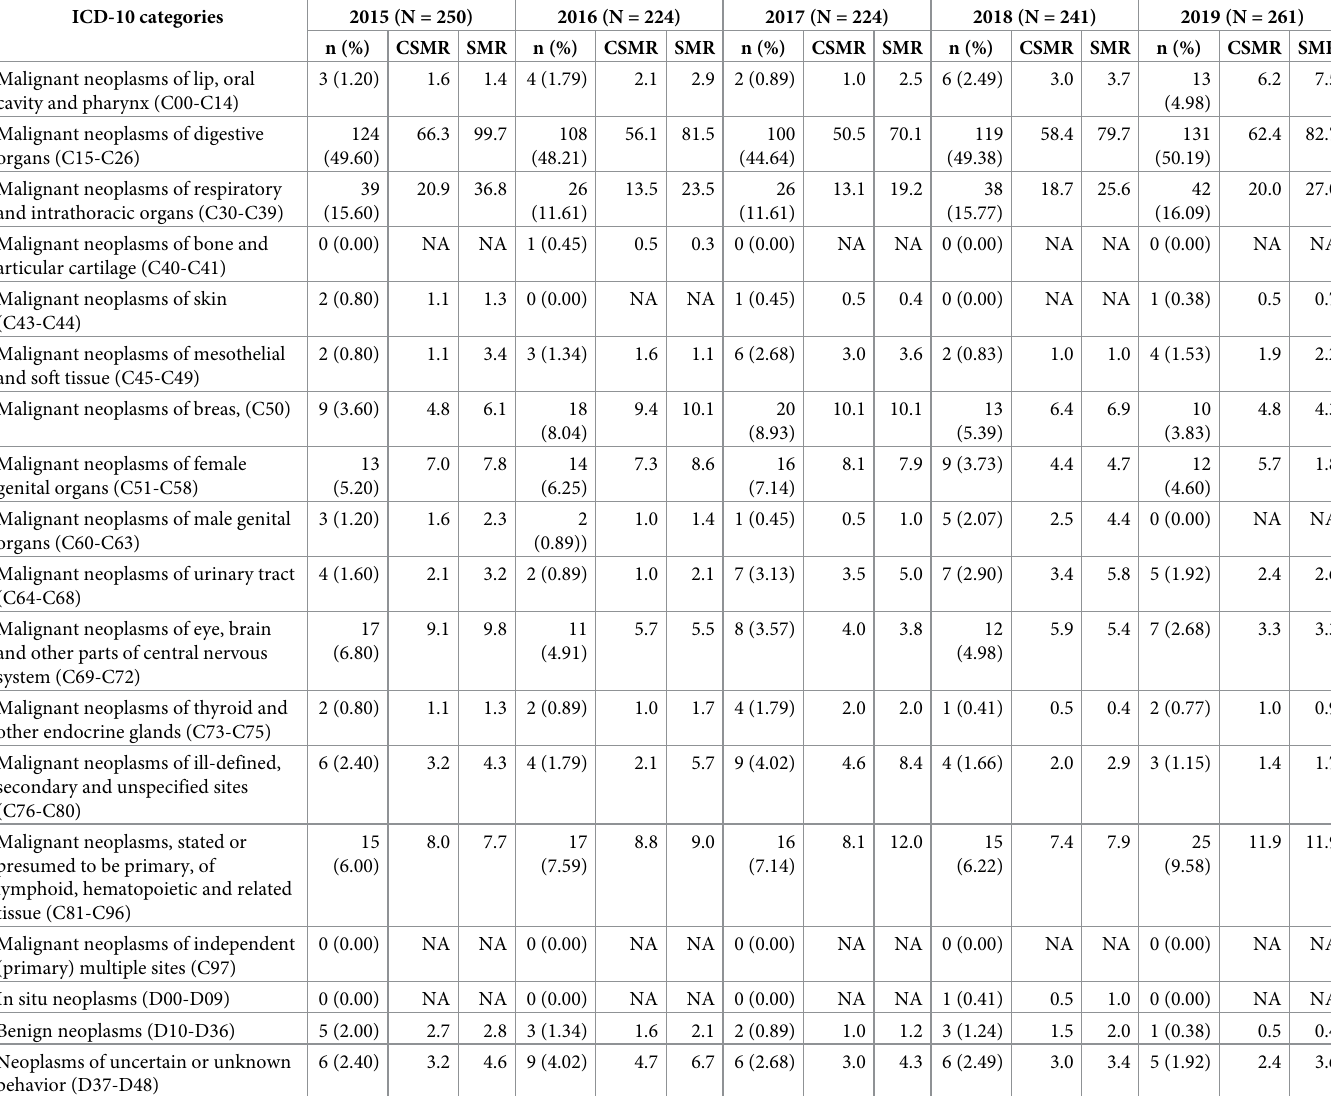
Table 6. Death status of people with intellectual disabilities by ICD-10-based neoplasm diseases from 2015 to 2019. ICD-10